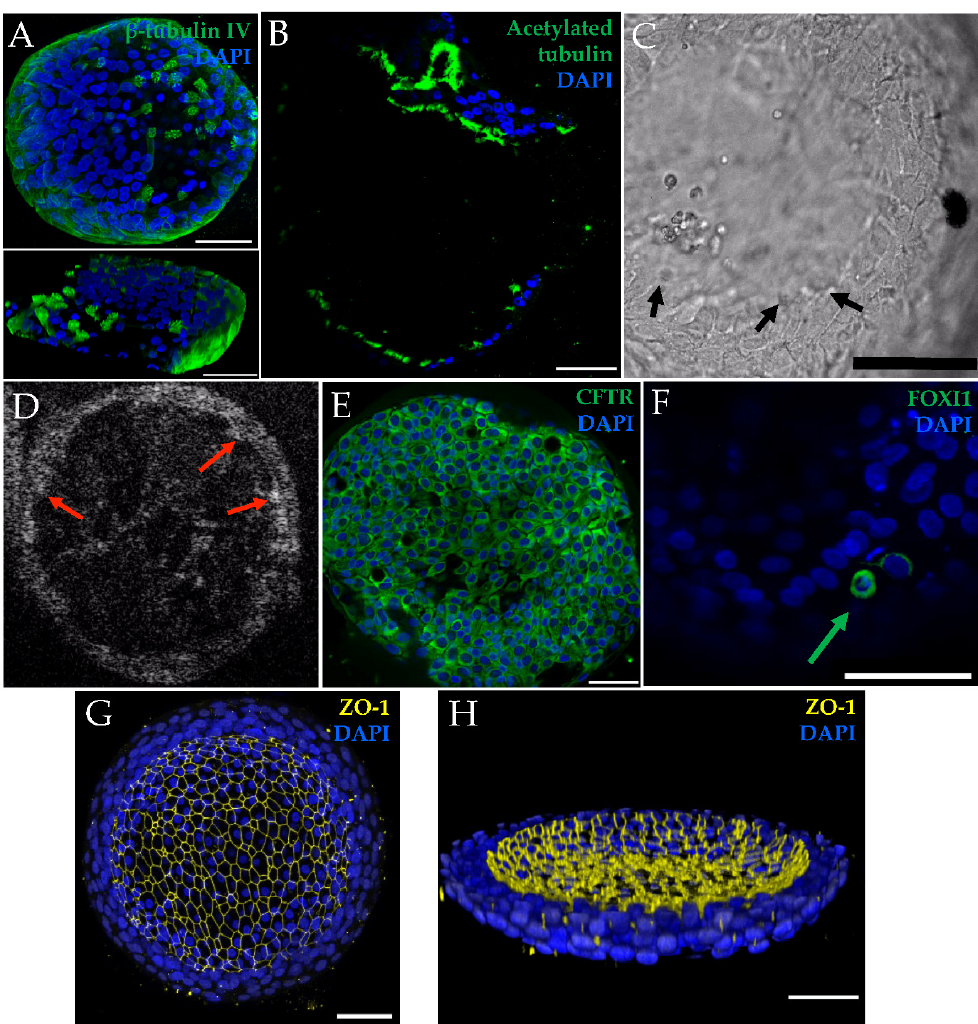
Figure 4. Other markers of airway epithelial differentiation are shown in selected images from non-CF and CF organoids. ( A ) Top panel is a confocal maximal projection of β -tubulin IV in F508del/G551D organoid with a 3-D reconstruction in the bottom panel that was sliced into to show cilia protruding. Scale = 50 µm. ( B ) Cross-section stained with acetylated tubulin in a non-CF organoid. Scale = 50 µm. ( C ) Light microscopy image of still cilia (arrows) in a non-CF organoid. Scale = 100 µm. ( D ) µOCT image of still cilia (arrows) in a non-CF organoid. ( C , D ) Stills correspond with Videos S3 and S4 . ( E ) Organoids also expressed CFTR, as seen in this representative example from F508del/R117H-5T organoids; co-localizion with ZO-1, seen in a non-CF organoid, is shown in Figure S2 . Scale = 50 µm. ( F ) FOXI1-positive cell (arrow) in an F508del/F508del organoid. Scale = 50 µm. Maximal projection of tight-junction (ZO-1) staining ( G ) and a three-dimensional hemisphere demonstrating apical (luminal) localization in F508del/F508del organoids ( H ). Scale = 50 µ